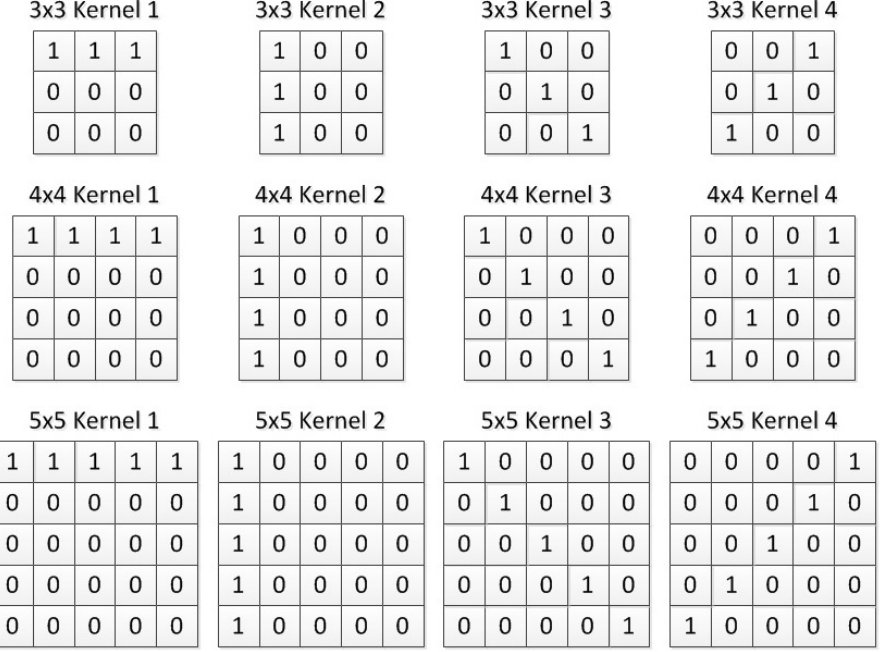
Figure 6. Convolution kernel of different